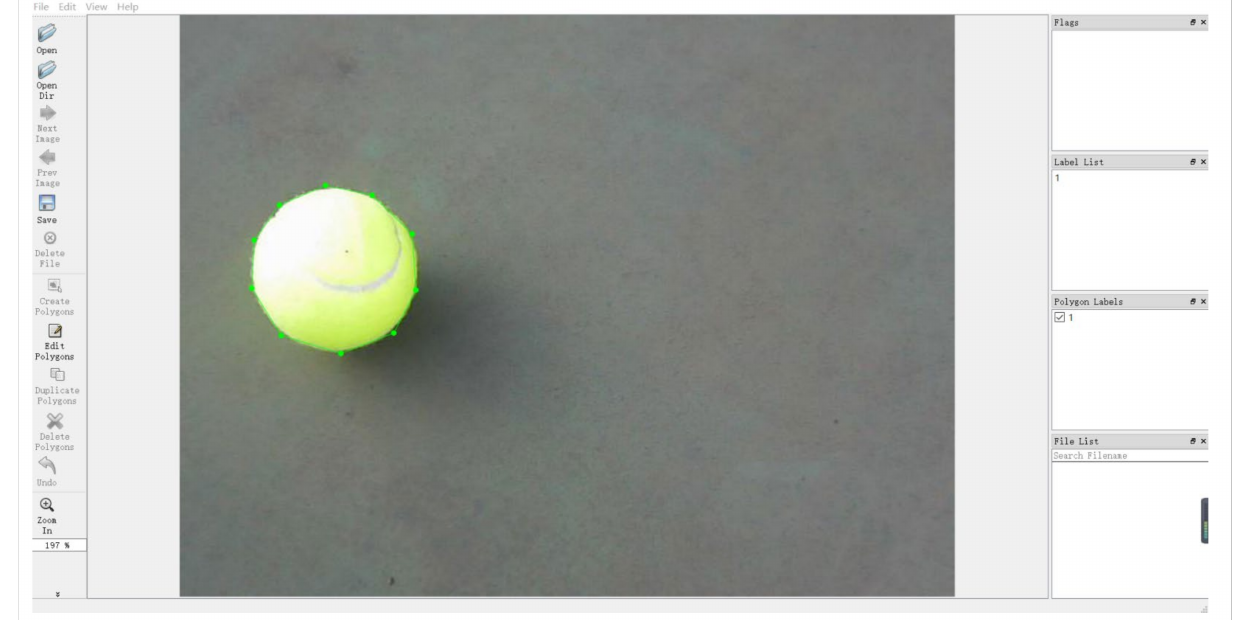
Figure 12. Sample of marked tennis images.